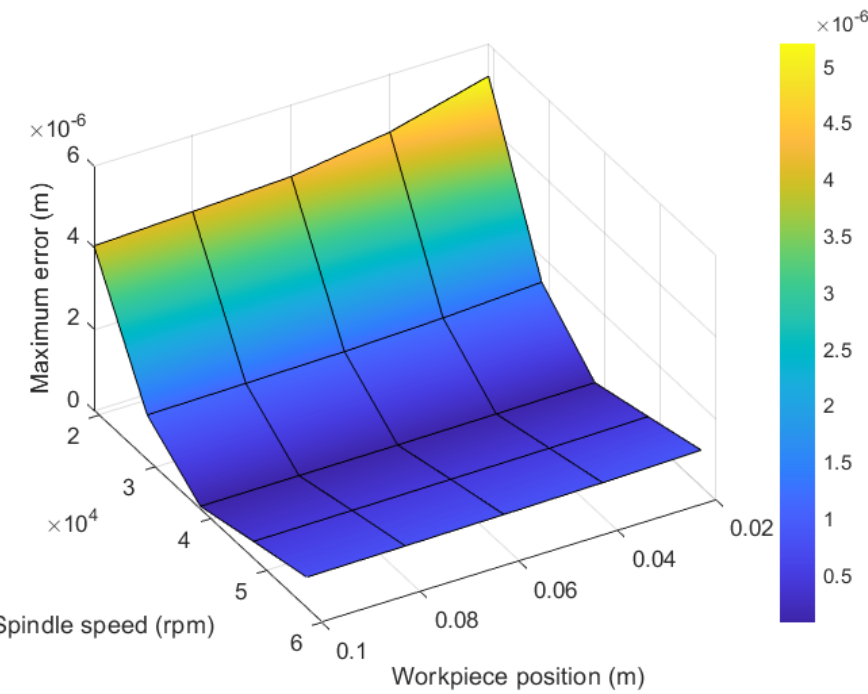
Figure 12. Maximum error possible for electrospindle.